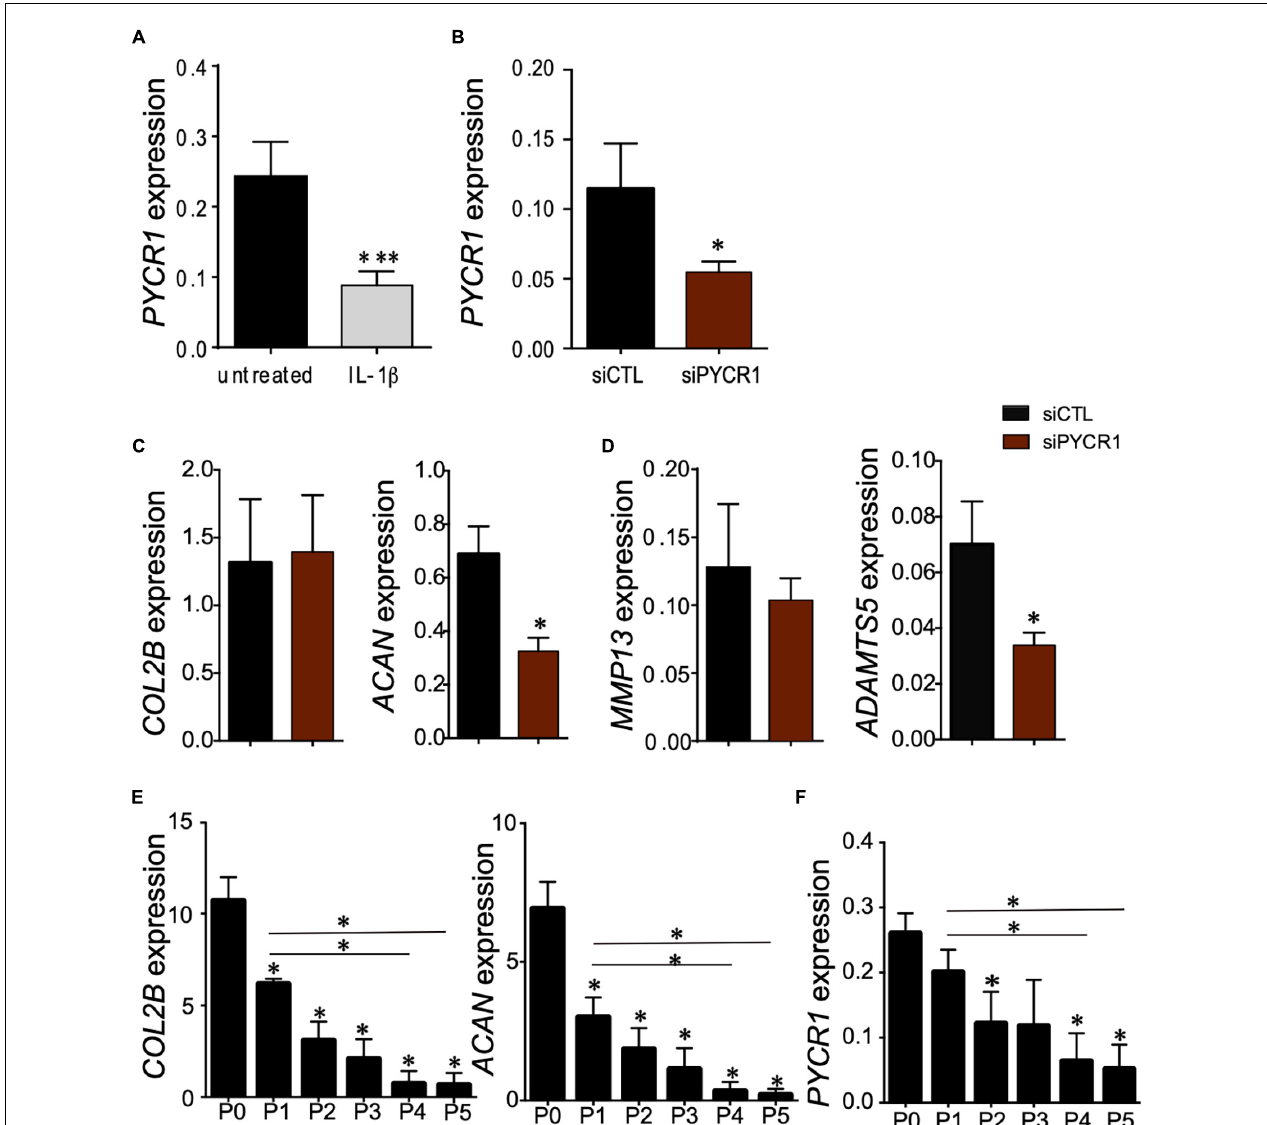
FIGURE 4 | Pycr1 silencing, a novel method to generate mouse IL-1 β -treated chondrocytes. (A) Scheme showing the generation of chondrocytes with OA features with IL-1 β treatment of freshly isolated chondrocytes. RT-qPCR analysis of Pycr1 expression level in untreated healthy chondrocytes (untreated) and in IL-1 β -treated chondrocytes (IL-1 β ). (B) RT-qPCR analysis of Pycr1 expression level in chondrocytes transfected with a siRNA against PCYR1 (siPYCR1). (C) RT-qPCR analysis of the chondrocyte anabolic markers Col2B and Acan and (D) chondrocyte catabolic markers Mmp13 and Adamts5 in chondrocytes transfected with a control siRNA (siCTL) or a siRNA against Pycr1 (siPYCR1). (E) RT-qPCR analysis of the chondrocyte anabolic markers Col2B and Acan and (F) Pycr1 in mouse chondrocytes induced differently after serial passages in culture [from passage 0 (P0) to passage 5 (P5)]. Results represent the mean ± SEM of three independent experiments. Statistics: Mann–Whitney test, two-tailed. When not indicated P0 versus P1, P2, P3, P4, and P5. p -values < 0.05 ( ∗ ). OA, osteoarthritis; siRNA, small interfering